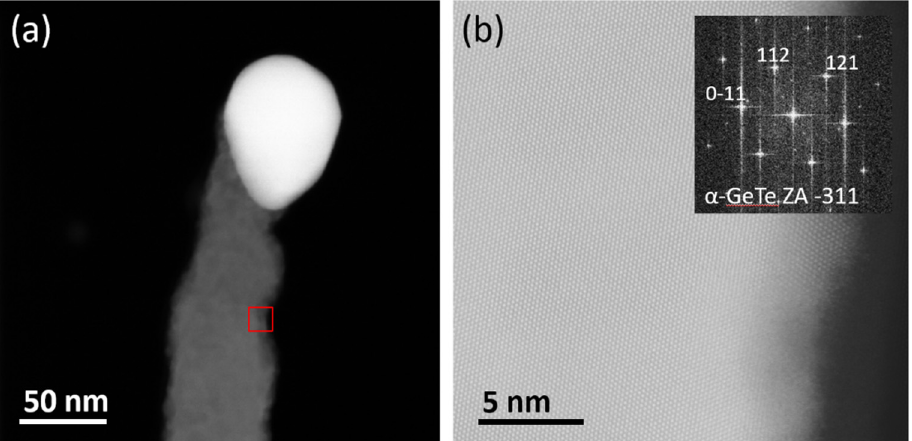
Figure 5. ( a ) STEM micrograph of an individual GeTe core NW; ( b ) enlarged view at a high resolution of the NW portion indicated by a red square. In the inset, the indexed diffraction pattern is obtained as FFT of the image in ( b ).